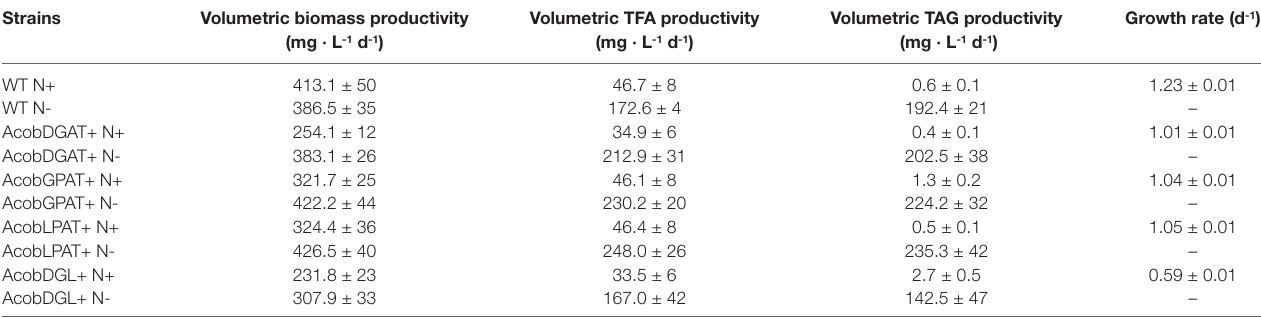
TABLE 1 | Growth rate and average volumetric productivities of biomass, total fatty acids (TFA), and triacylglycerols (TAG) for nitrogen replete (N+) and nitrogen deplete (N-) conditions.